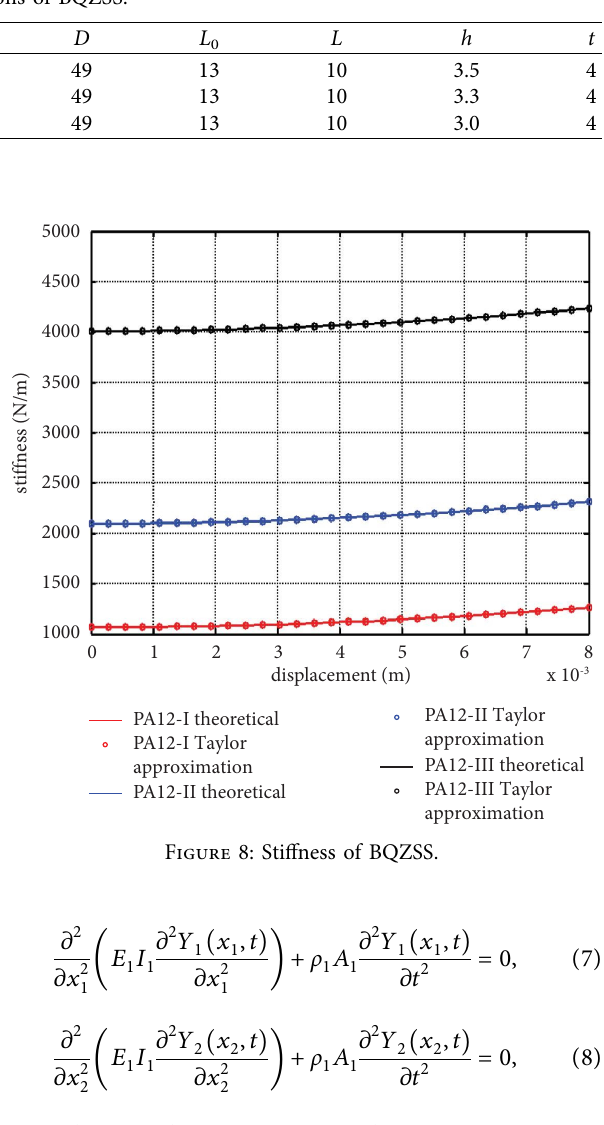
Table 2: Dimensions of BQZSS.